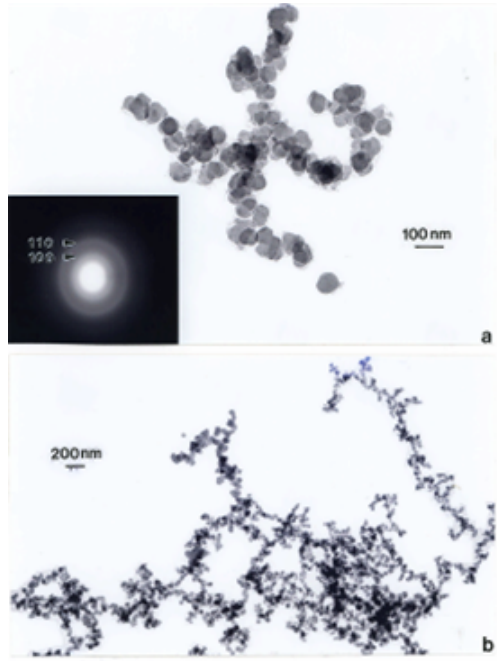
Figure 12: Particulate matter collected from a burning fire (TPM). (a) Small branched, aggregate fragment. The SAED pattern insert shows prominent graphite reflections. (b) Example of large, aggregated, branched particle. The image shows only about half of the aggregated particle.